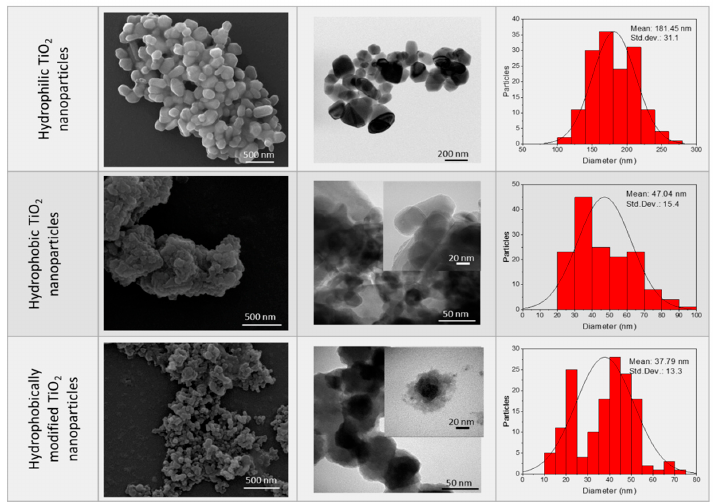
Figure 1. Scanning electron microscopy (SEM) and transmission electron microscopy (TEM) images and size histograms of the three different types of TiO 2 nanoparticles. Hydrophobic samples were negatively stained with phosphotungstic acid for TEM analysis.